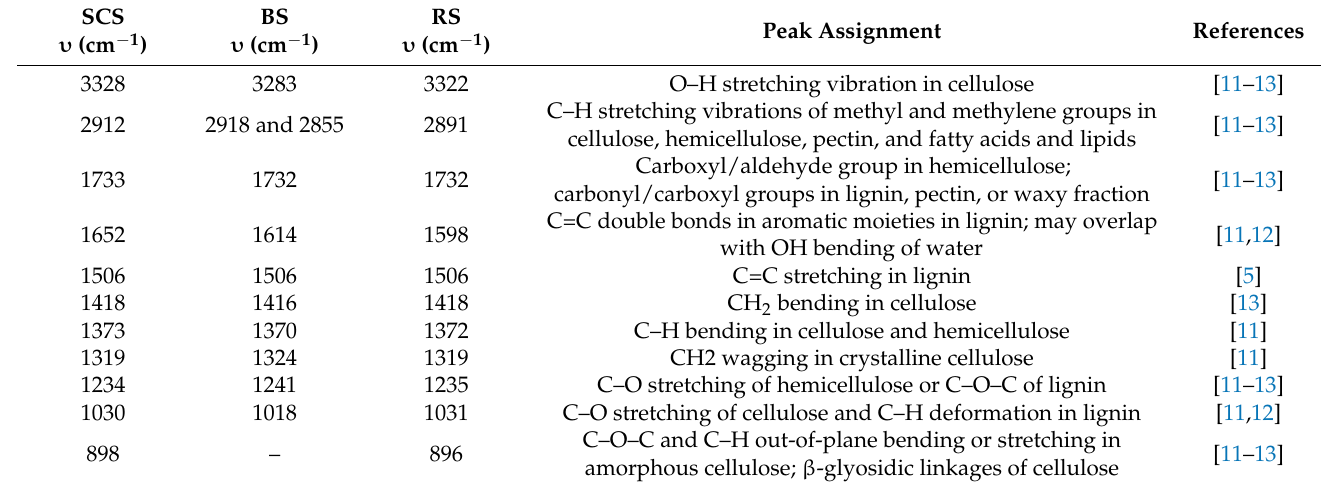
Figure 1. FTIR spectra of untreated BS, RS, and SCS fibers. Table 1. FTIR peaks and corresponding functional groups of SCS, BS, and RS [11 – 13].